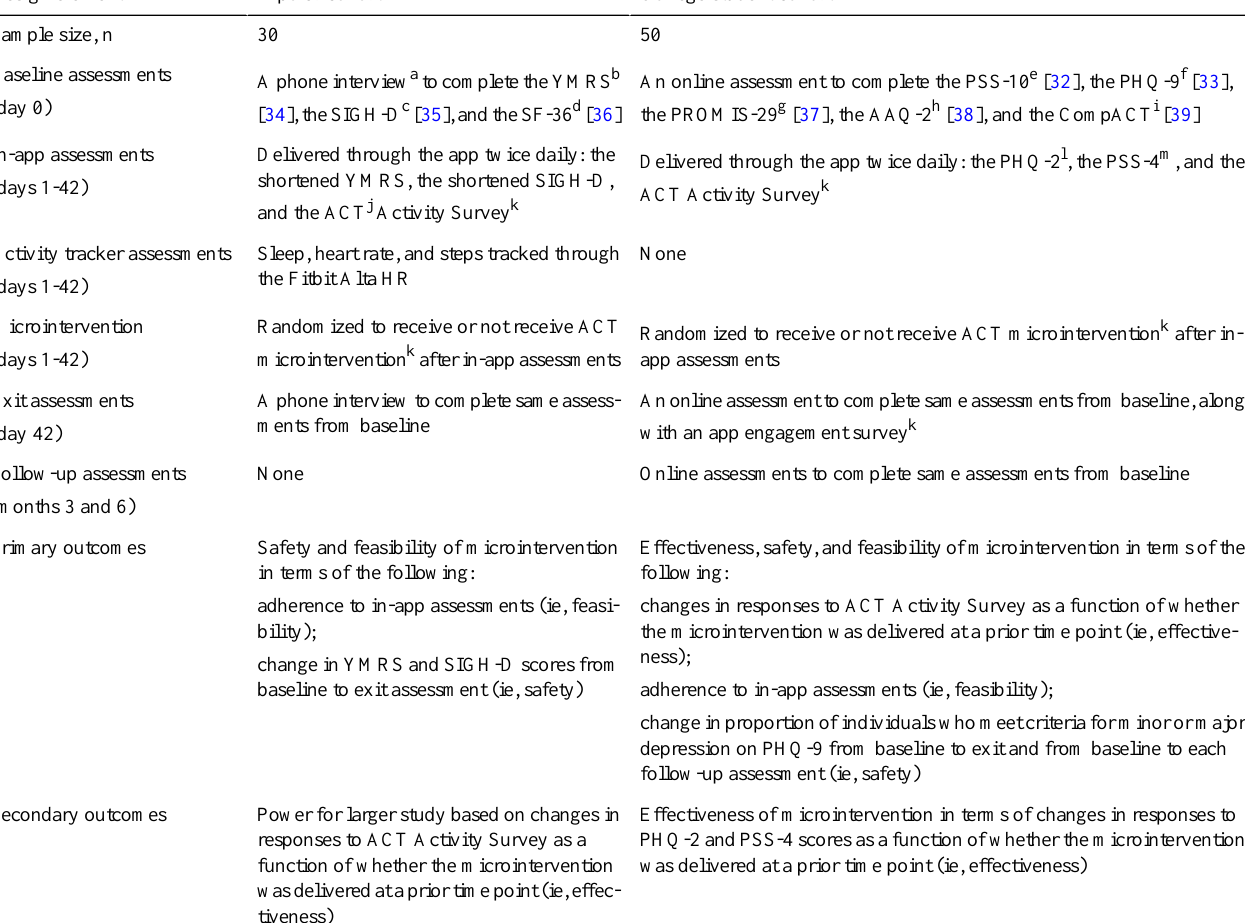
Table 1. Summary of study design and differences between cohorts.